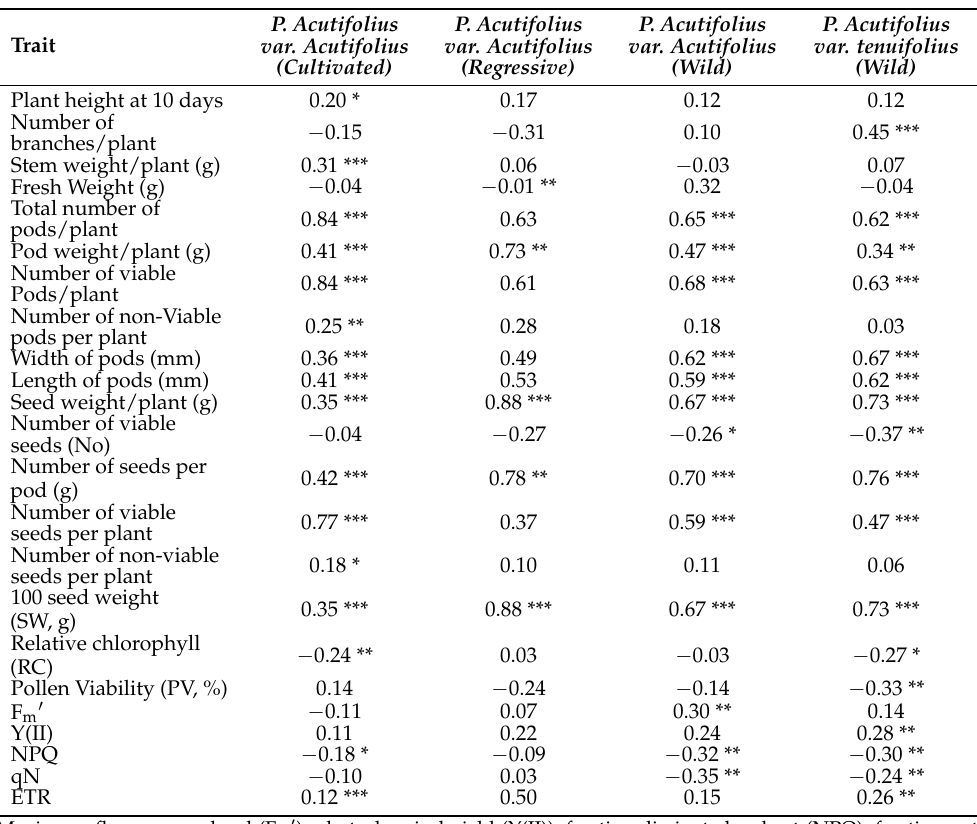
Table 1. Correlation coefficients between grain yield (GY) and different agronomic and physiological traits of the tepary bean genetic resource grown under acid soil and high temperature conditions.